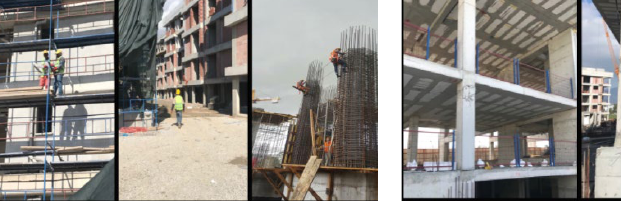
Figure 8. Workers wearing proper PPE but the way of working is not adequate